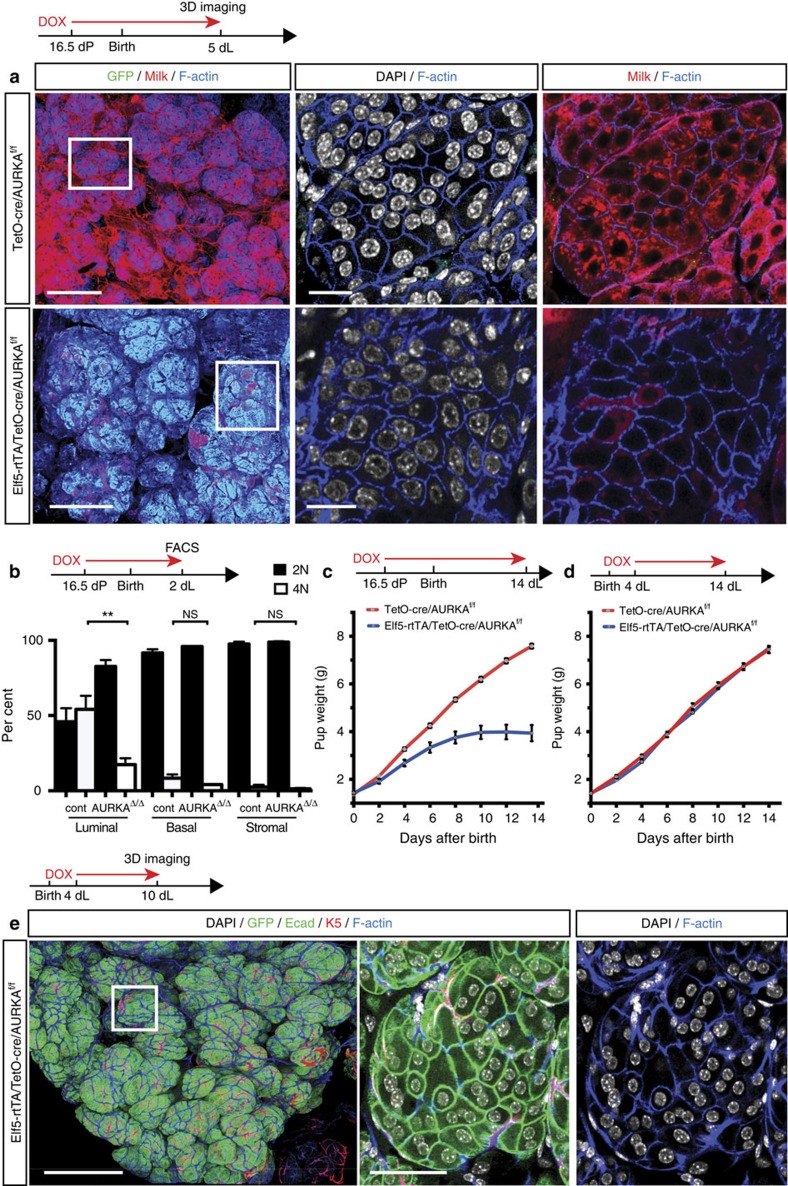
Temporal control of AURKA expression is important for the generation of binucleated alveolar cells.(a) Whole-mount 3D confocal images of ductal portions and optical sections from the enlargements for Elf5-rtTA/TetO-cre/AURKAf/f gland (bottom) compared with control TetO-cre/AURKAf/f mammary gland (top). The whole-mounts were labelled for DAPI (white), GFP (green), milk (red) and F-actin (blue). The animals were given DOX food from 16.5 dP until imaging analysis at 5 dL (n=4 mice). Scale bars: 100 μm (whole-mounts); and 20 μm (optical sections). (b) Bar graph of FACS data showing percentage of cells containing 2N or 4N DNA content in the luminal, basal and stromal cell compartments from Elf5-rtTA/TetO-cre/AURKAf/f (AURKAΔ/Δ) and control AURKAf/f mice at 2 dL, after DOX induction from 16.5 dP. Error bars represent mean±s.e.m. (n=3 mice). **P<0.01. (c) Body weight of pups nursed by Elf5-rtTA/TetO-cre/AURKAf/f dams versus littermate control TetO-cre/AURKAf/f dams. DOX food was given from 16.5 dP to 14 dL (six pups per dam; n= 3 dams). P<0.0001. (d) Body weight of pups nursed by Elf5-rtTA/TetO-cre/AURKAf/f dams versus control dams. DOX was given from 4 to 14 dL (six pups per dam; n=2 dams). Error bars represent mean±s.e.m. (no significant difference). (e) Representative whole-mount 3D confocal image of a ductal portion from Elf5-rtTA/TetO-cre/AURKAf/f mice. DOX food was given to mice from 4 dL until collection at 10 dL. The whole-mount was labelled for DAPI (white), E-cadherin/GFP (green), K5 (red) and F-actin (blue) to highlight the architecture of the gland (n=2 mice). Middle and right panels show optical sections from the selected area in the left panel. Most cells remain binucleated. Scale bars: 200 μm (whole-mount); and 30 μm (optical sections).